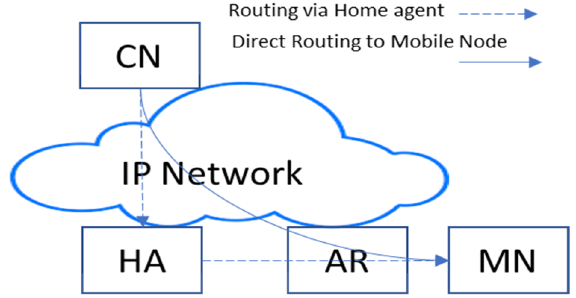
Figure 3. Route optimization in Mobile IPv6.